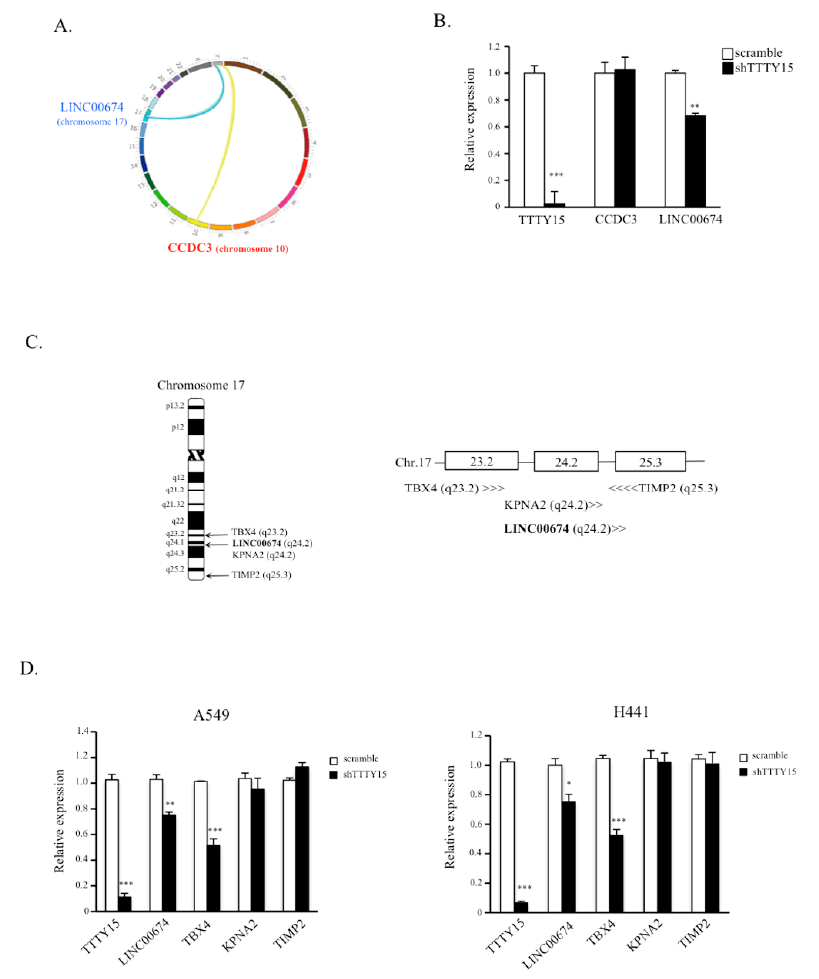
Figure 4. T-box transcription factor 4 (TBX4) is a potential target gene of TTTY15 and its expression may be regulated by TTTY15 . ( A ) The TTTY15 interaction map. ( B ) Comparison of the expression levels of CCCD3 and LINC00674 between TTTY15 -knockdown cells and scramble cells. ( C ) The gene locus on chromosome 17 and a schema of TTTY15 -targeted LINC00674 (bold) and the protein-coding genes near LINC00674 . ( D ) Expression levels of protein-coding genes located near the LINC00674 gene in TTTY15 knockdown cells and scramble cells. Data are presented as the mean ± SD; * p < 0.05, ** p < 0.01, *** p < 0.001. Statistical analysis was conducted by Student’s t -test ( n = 3).